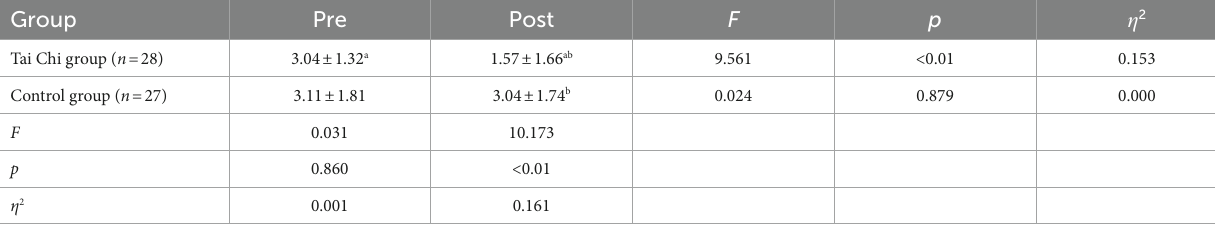
TABLE 5 Results of repeated measures ANOVA c for arousal difference (M ± SD). Group Pre